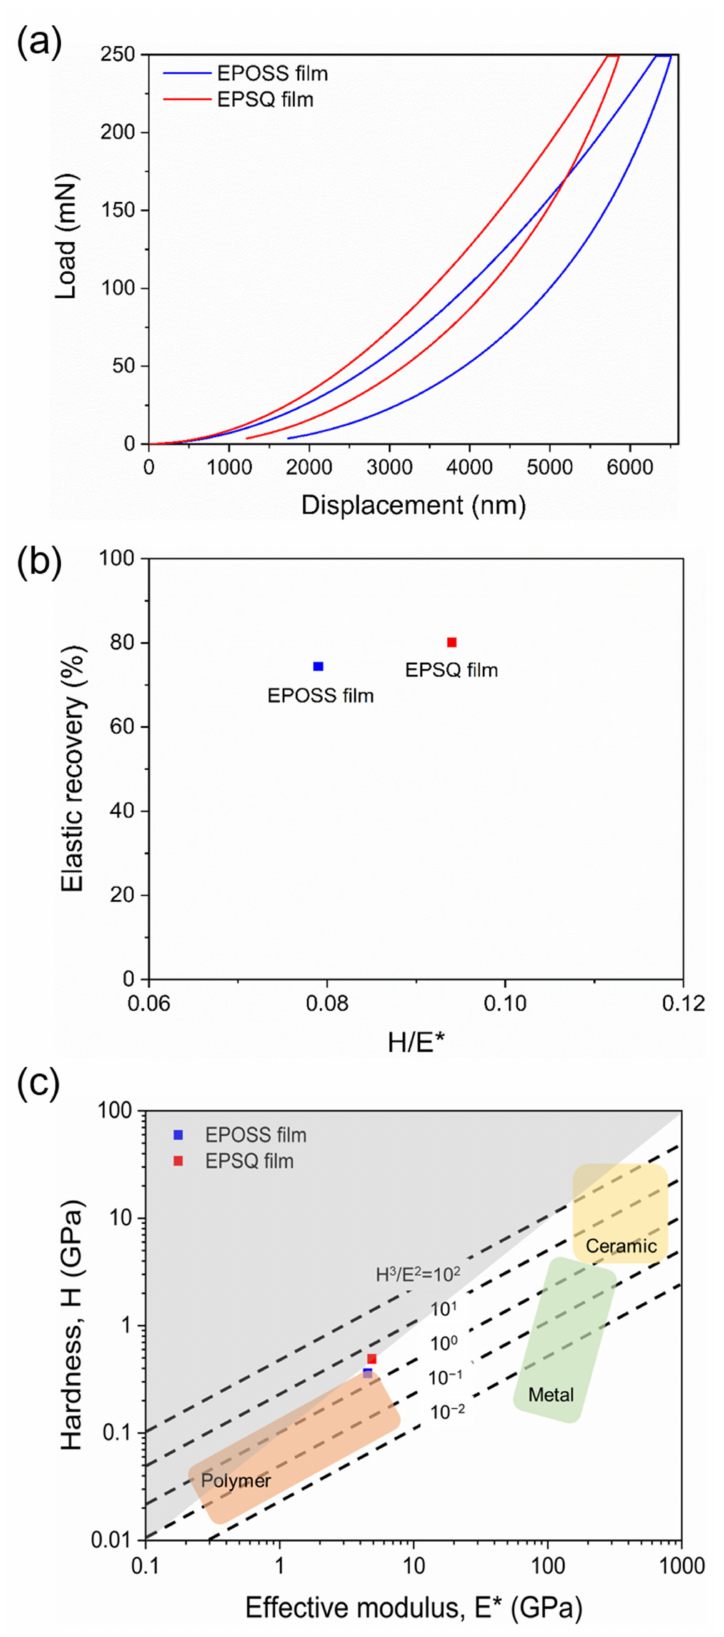
Figure 5. Nanoindentation characterization of EPOSS and EPSQ films. ( a ) Load–displacement curves, ( b ) elastic recovery–H/E* plot, and ( c ) hardness–effective modulus curve